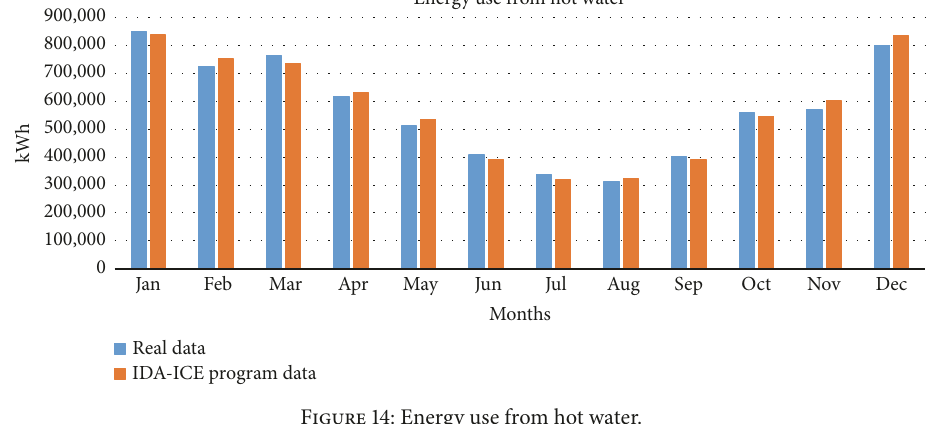
Figure 14: Energy use from hot water.